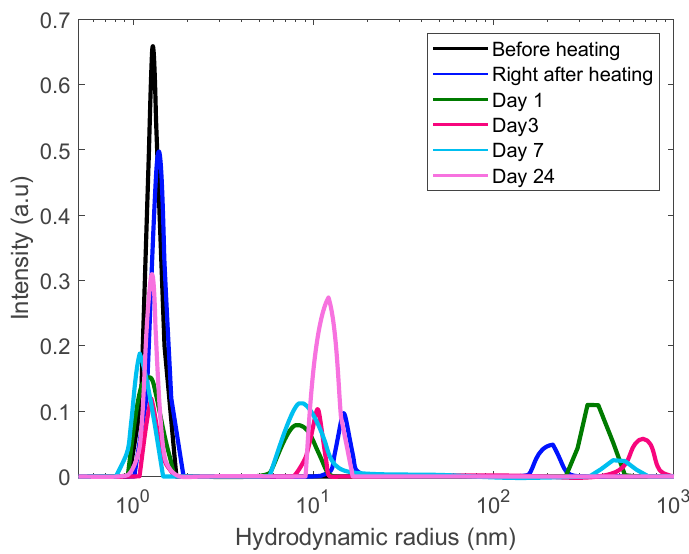
Figure 8. DLS size distribution analysis of a 60 mg/mL lysozyme sample heated for 30 min at 80 °C to trigger aggregation and monitored for 24 days.